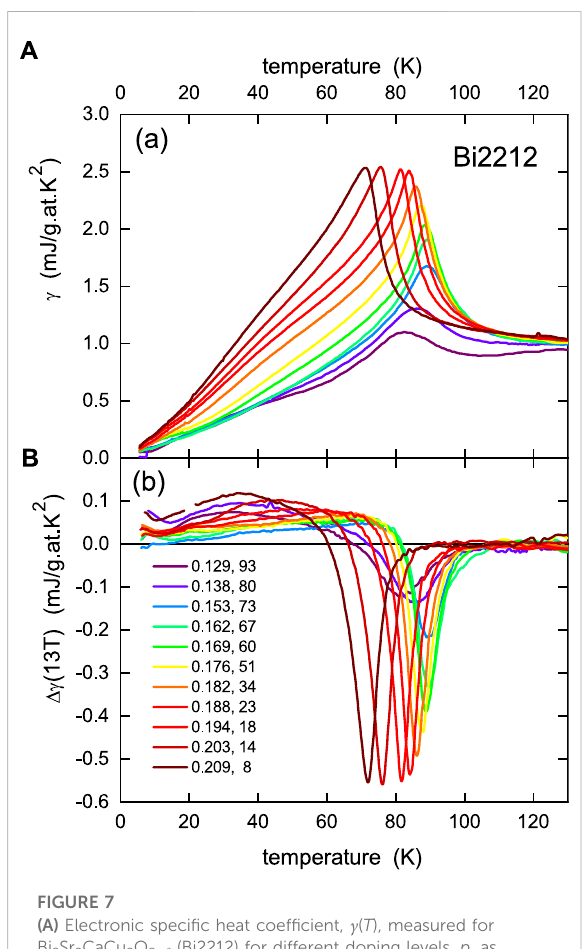
FIGURE 7 (A) Electronic speci fi c heat coef fi cient, γ ( T ), measured for Bi 2 Sr 2 CaCu 2 O 8+ δ (Bi2212) for different doping levels, p , as annotated in the legend in the lower panel. The legend shows p and Δ E vHs values as in Figure 6 (B) . Panel (B) shows the difference Δ γ (13, T ) = γ (13, T ) − γ (0, T ) between the speci fi c